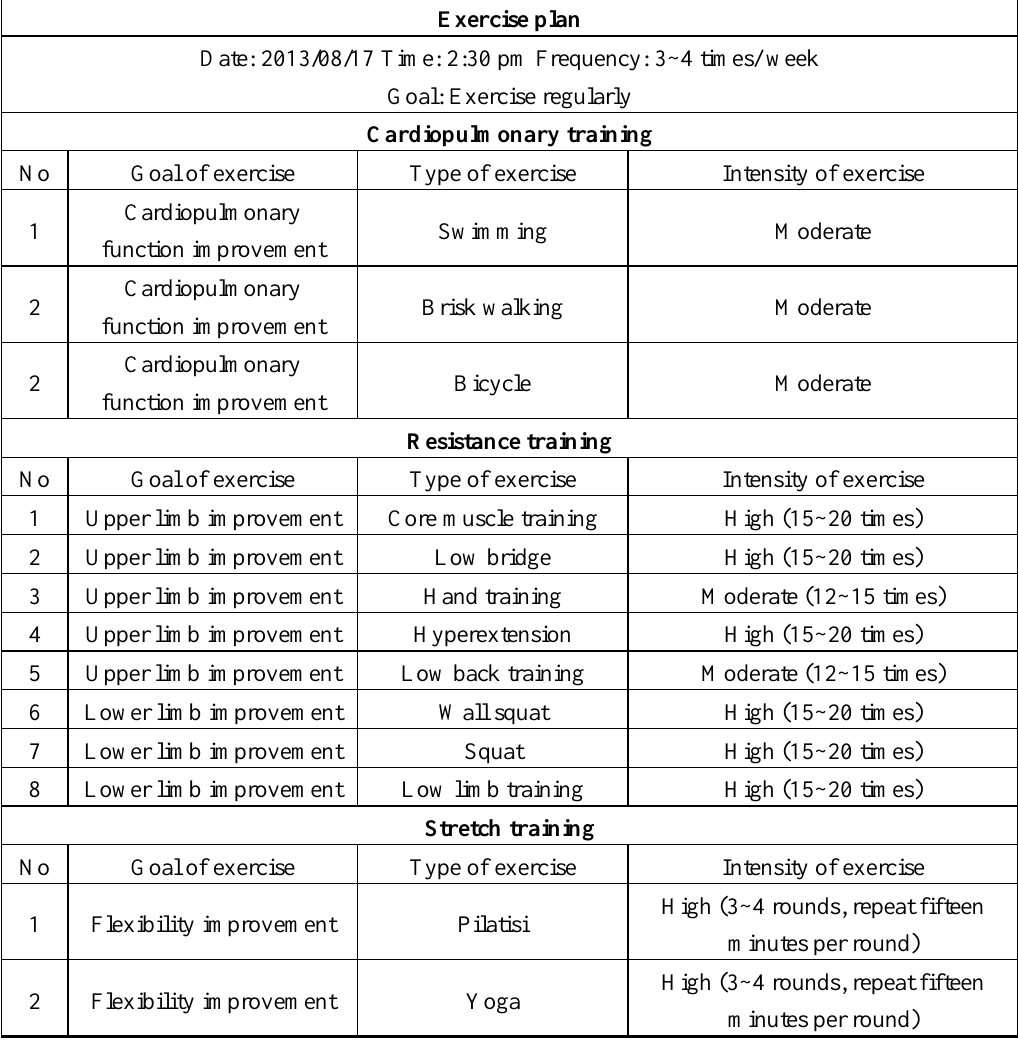
Table 9. Personalized exercise plan generated by UFIT (Plan